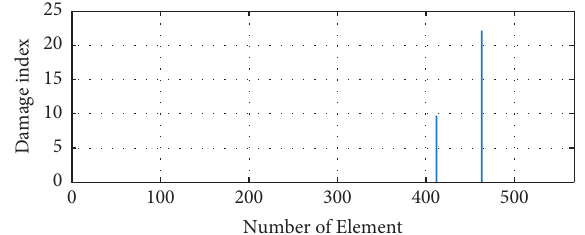
Figure 32: Results of multidamage case D3 using MCA-DI (building with the unsymmetrical distribution of columns).